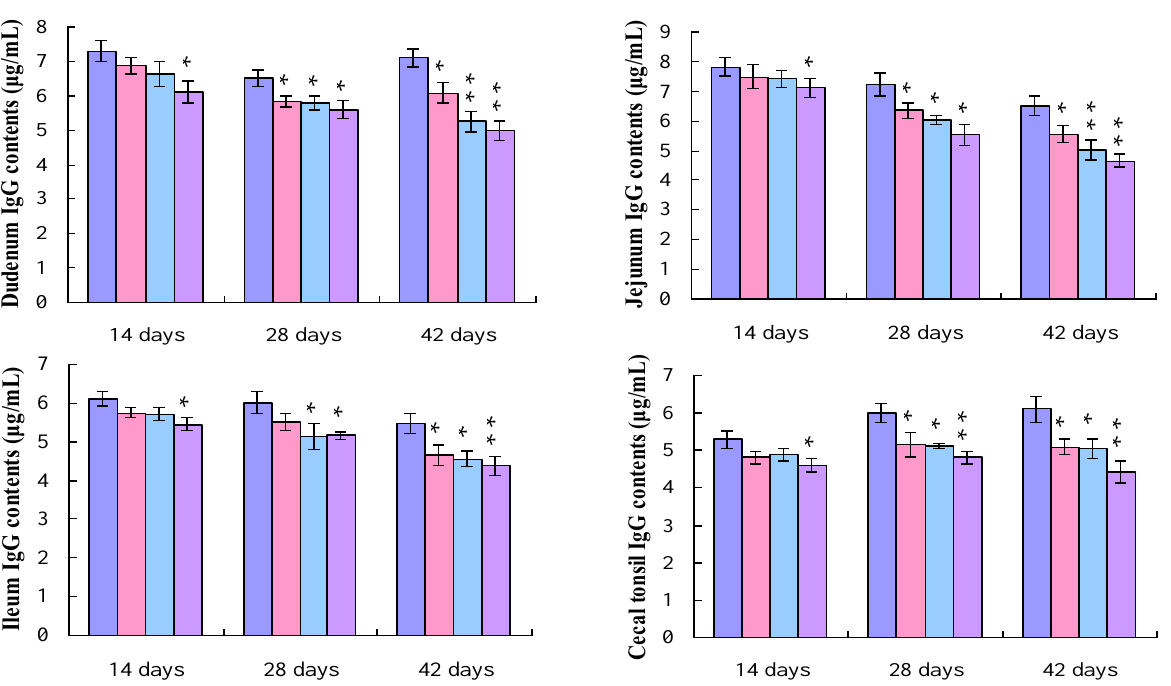
Data are presented with the means ± standard error ( n = 5); * p < 0.05, ** p < 0.01, compared with the control group; Data were analyzed by variance (ANOVA) test of SPSS 16.0